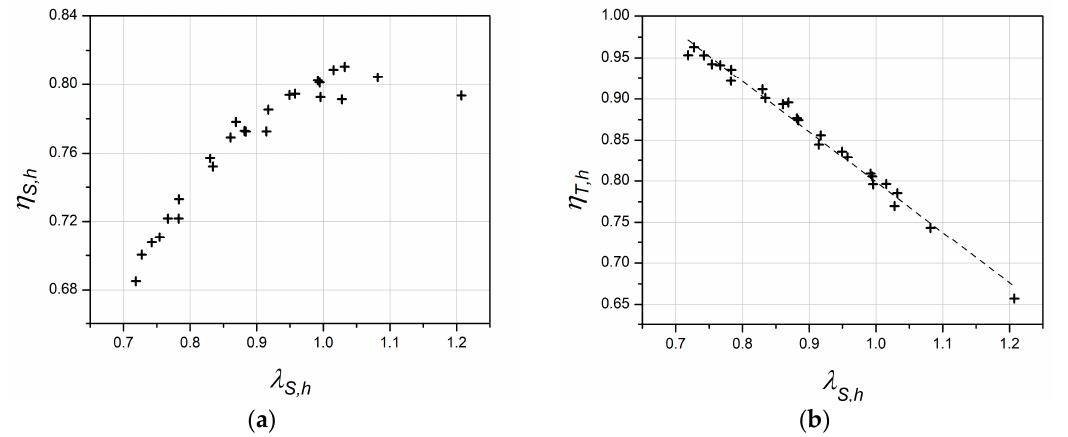
Figure 11. The high load results. ( a ) Scavenging efficiency; ( b ) trapping efficiency.